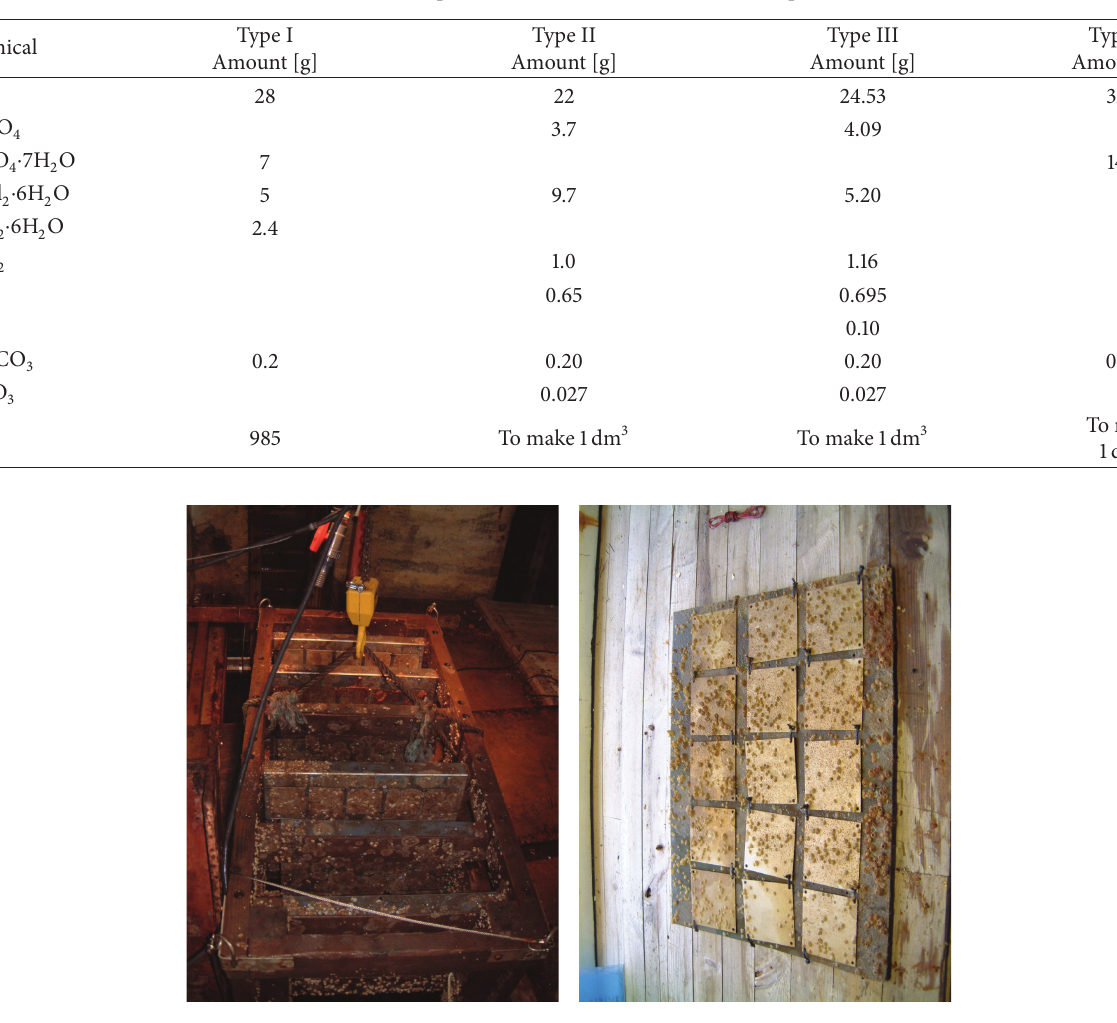
Figure 3: Test arrangement for planned interval immersion test, the test rack for all eight materials, and PVC back plate with AISI 304 type stainless steel